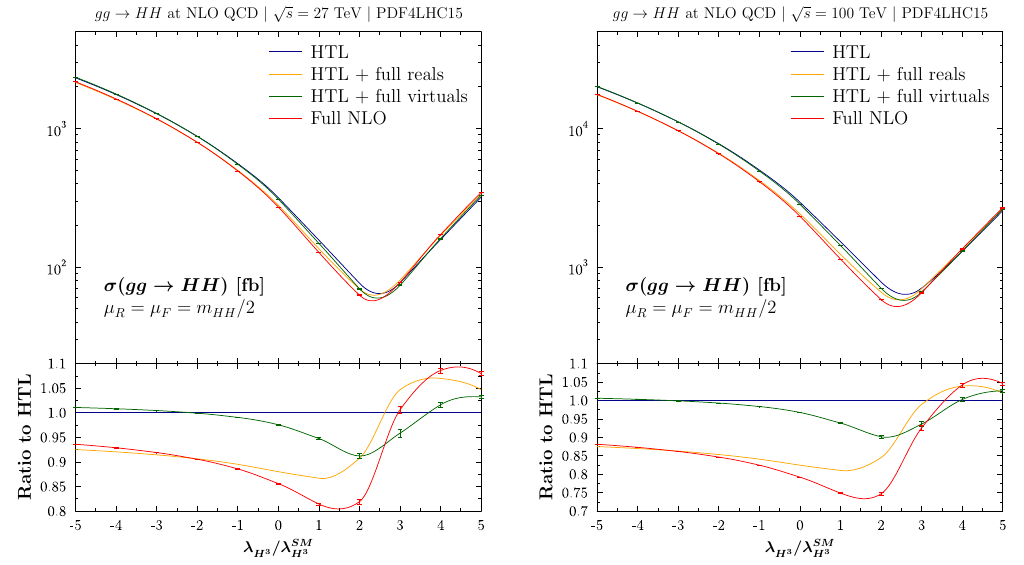
Figure 17 . Same as (cid:12)gure 16 but for c.m. energies of 27 (left) and 100 (right)